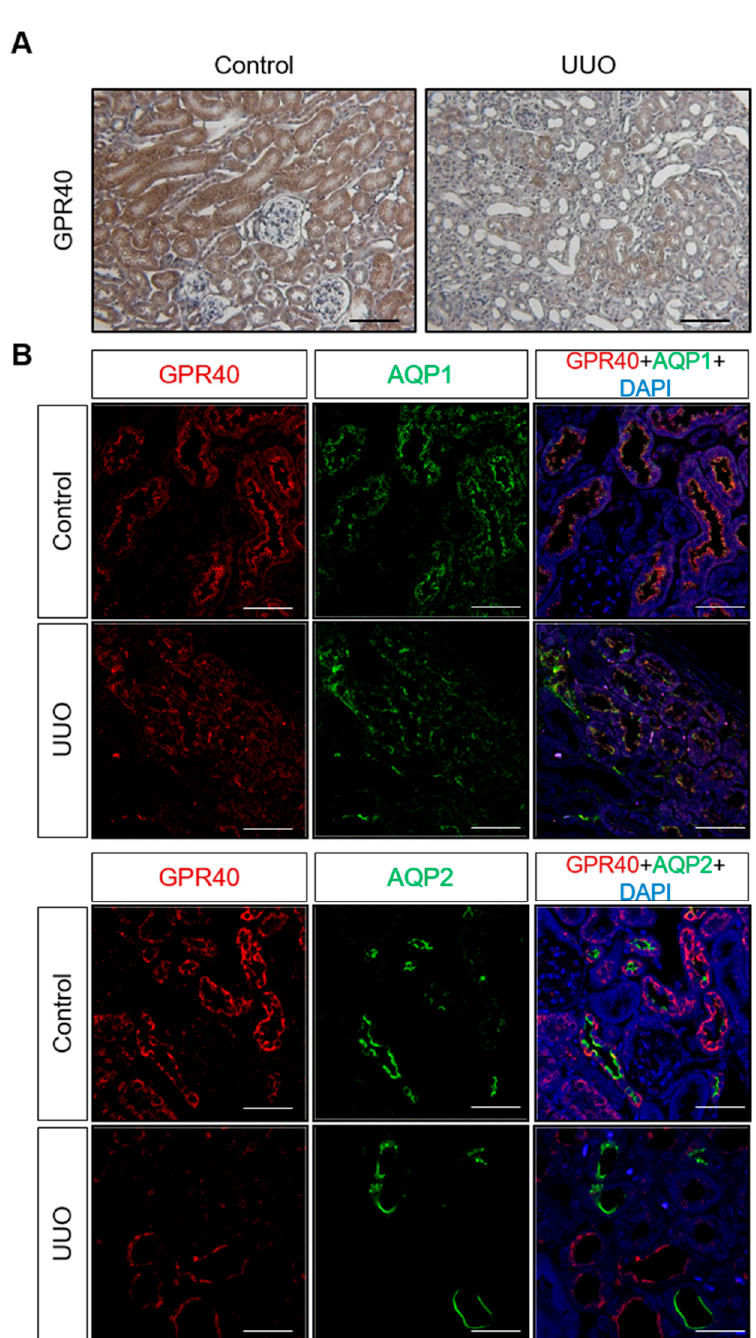
Figure 2. ( A ) Immunohistochemistry of G-protein-coupled receptor 40 (GPR40) expression in the control and ureteral obstructed kidneys of unilateral ureteral obstruction (UUO) mice (original magnification × 200). Bar = 100 µ m. ( B ) Immunofluorescence staining of GPR40 in aquaporin-1 (AQP1)- and AQP2-positive renal tubules of the control and ureteral obstructed kidneys (original magnification × 400). Bar = 50 µ m.